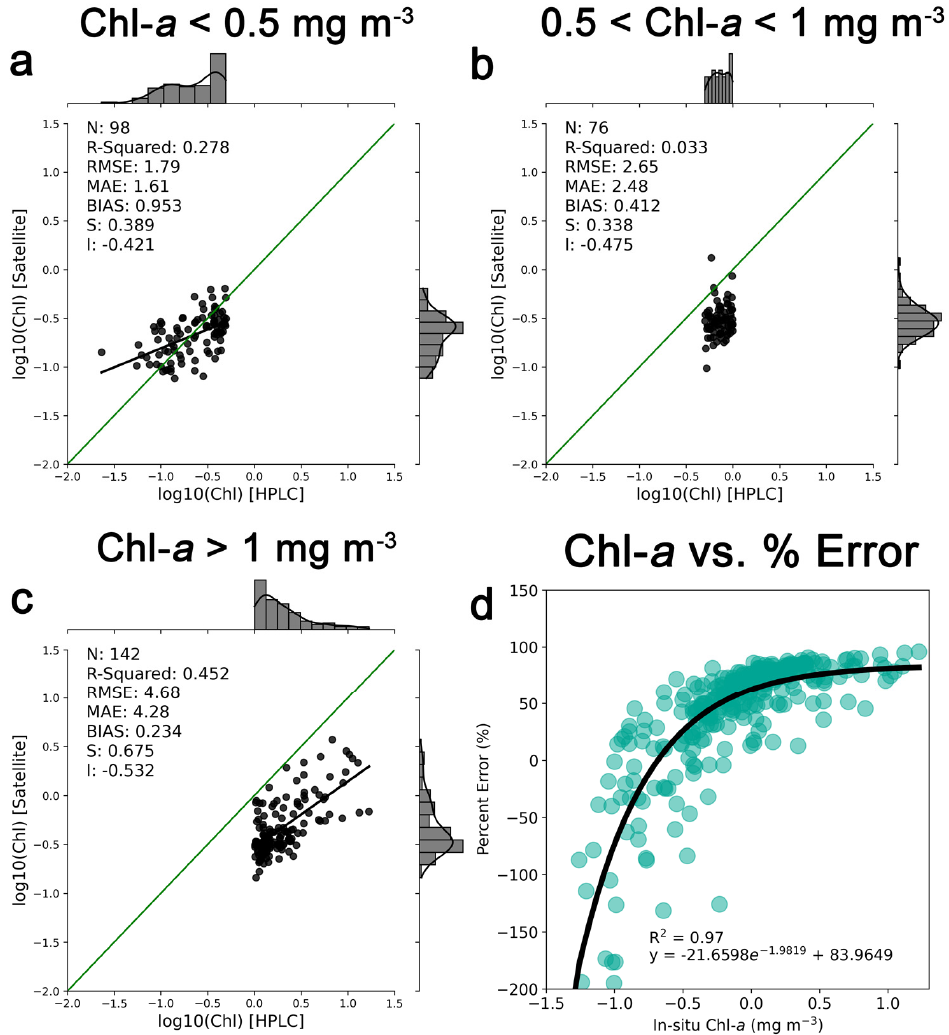
Figure 3. Comparison of the performance of the CCI product satellite Chl -a for low Chl -a (<0.5 mg m − 3 ) ( a ), intermediate Chl -a (0.5 mg m − 3 ≤ Chl -a < 1 mg m − 3 ) ( b ) and high Chl -a ( ≥ 1 mg m − 3 ) ( c ) in the Western Antarctic Peninsula waters. The green line represents the 1:1 line (ideal correspondence).